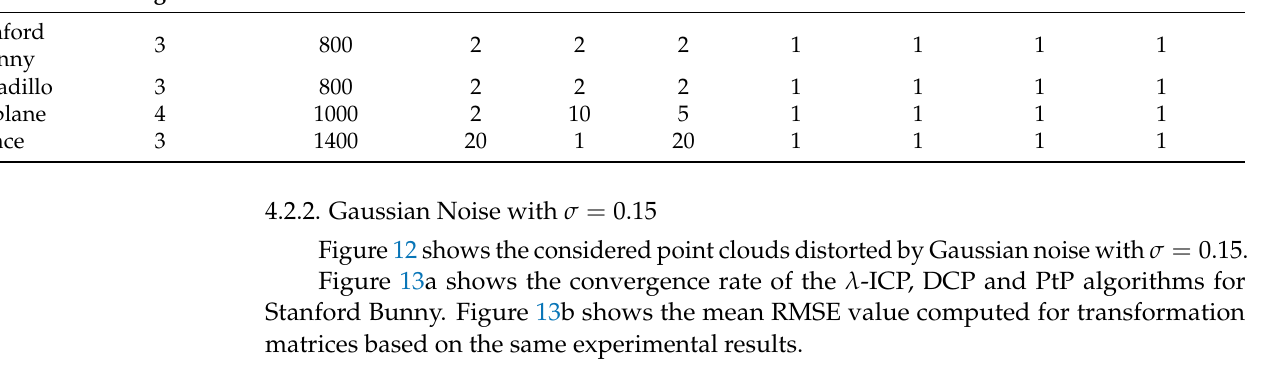
Table 2. Parameters of the λ -ICP algorithm for the case of Gaussian noise with σ = 0.05. Number